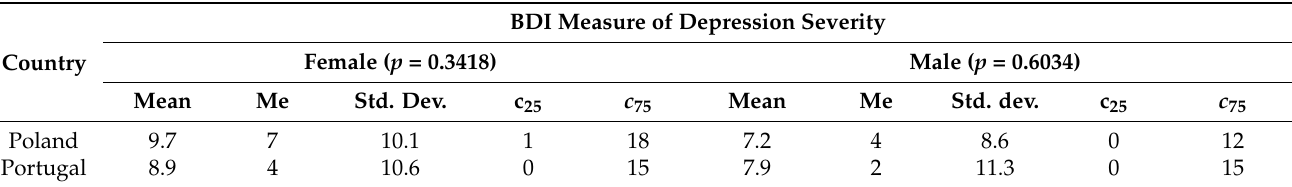
Table 2. Measures of depression severity in Poland and Portugal by gender.